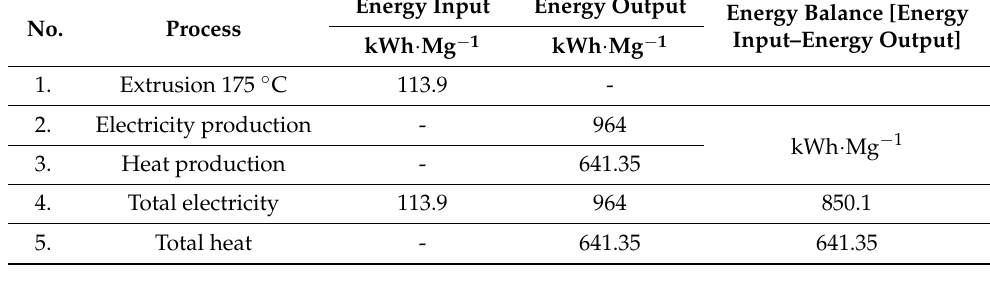
Table 11. The energy balance of biogas generated from Silphium perfoliatum L. extruded at 175 ◦ C.